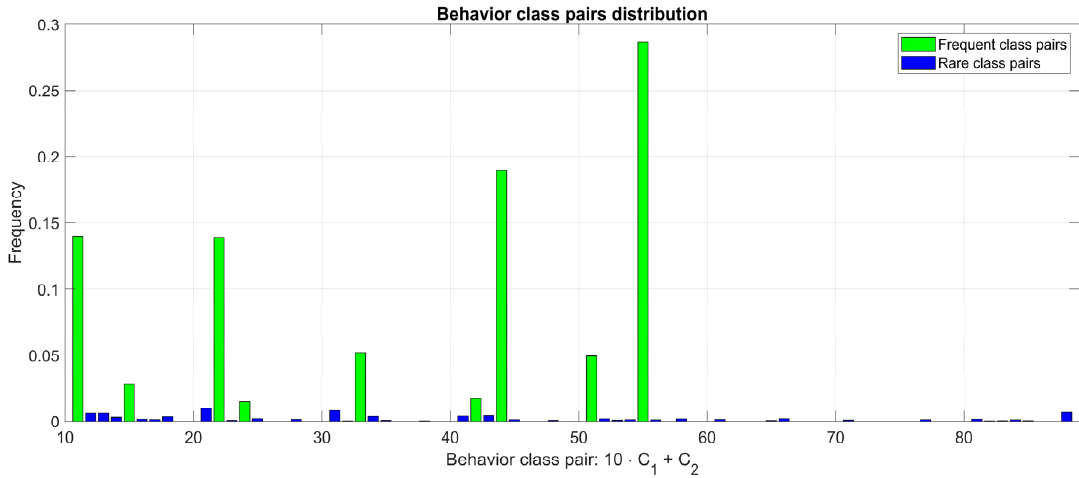
Figure 7. Class pairs frequency.